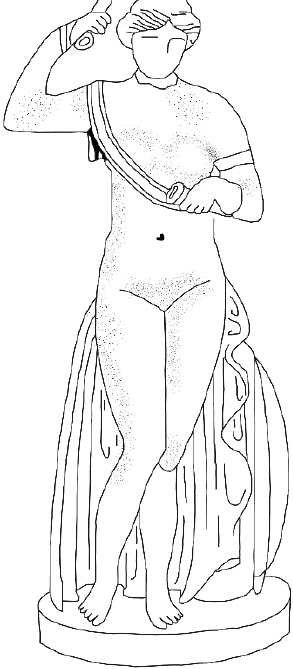
Figure 12. A reconstruction of the Aphrodite Armata statue from the House of Theseus at Nea Paphos. Digital drawing by J.M. Gordon, after Daszewski 1982, p. 199, Figure 1 [77].